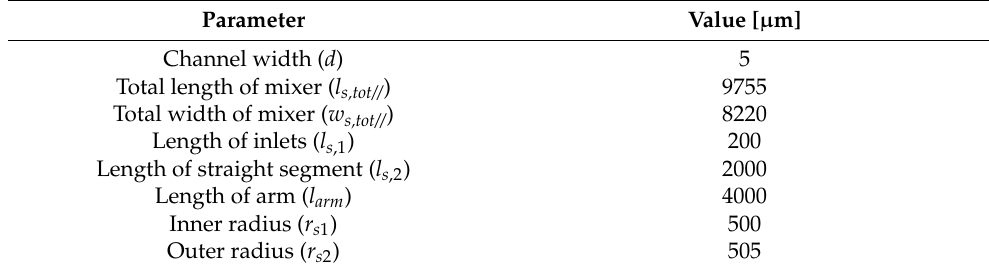
Table 2. Micromixer geometrical parameters.